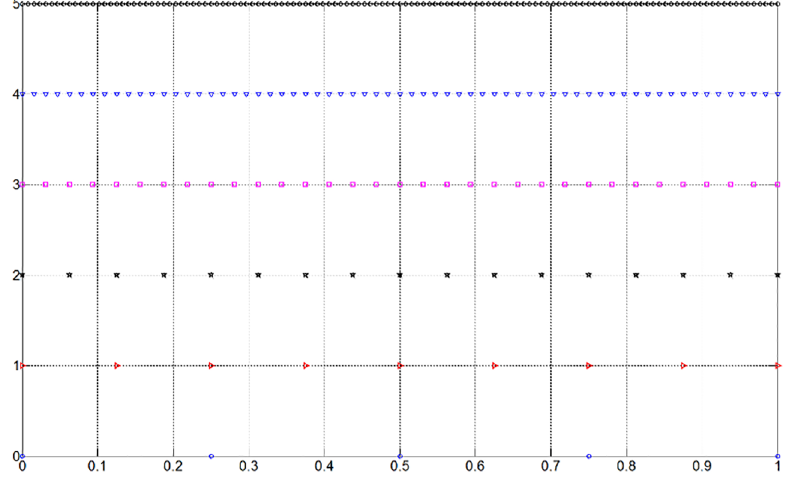
Fig 1. Dyadic grids on [0,